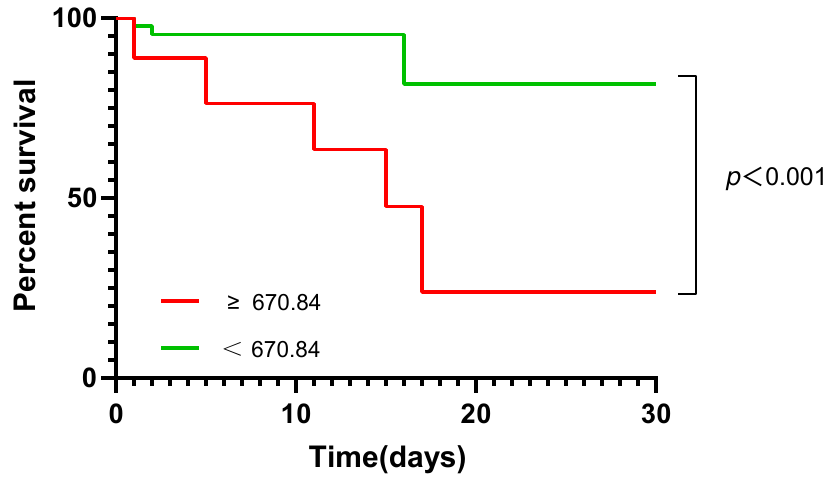
Figure 6. Kaplan–Meier analysis of 30-day mortality in CAP patients. The analysis was stratified by AnxA1 level. The AnxA1 cutoff (670.84 ng/mL) was an optimal retrospectively calculated value.